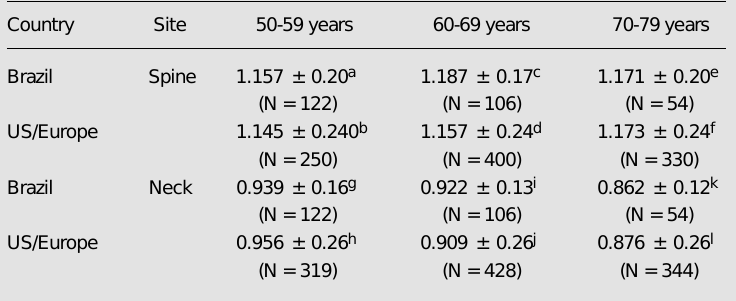
Table 7 - Comparison of Brazilian and US/European* male populations for lumbar spine and femoral neck bone mineral densities (g/cm 2 ) stratified by decade. Data were analyzed statistically by the Student t -test. No statistical differences were detected between measurements except c x d (P = 0.02). *Lunar reference data from Ref. 21.